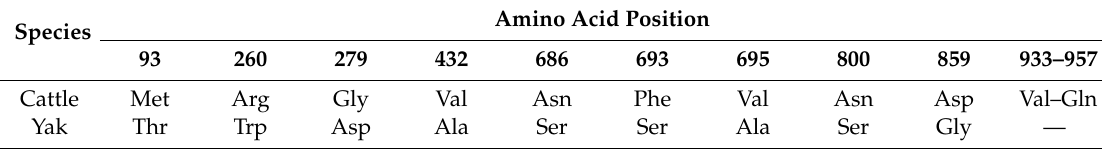
Table 5. Amino acid di ff erences in the coding sequences of bovine and yak KDM4B. Amino Acid Position Species 93 Cattle Met